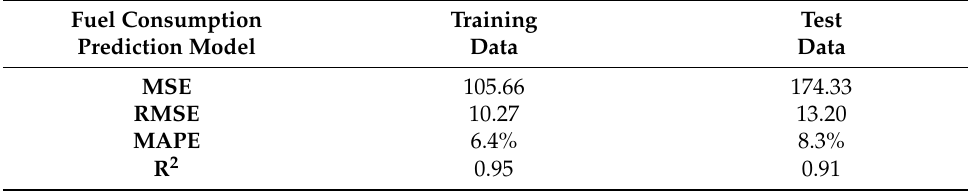
Table 11. Statistical parameters of the developed model.